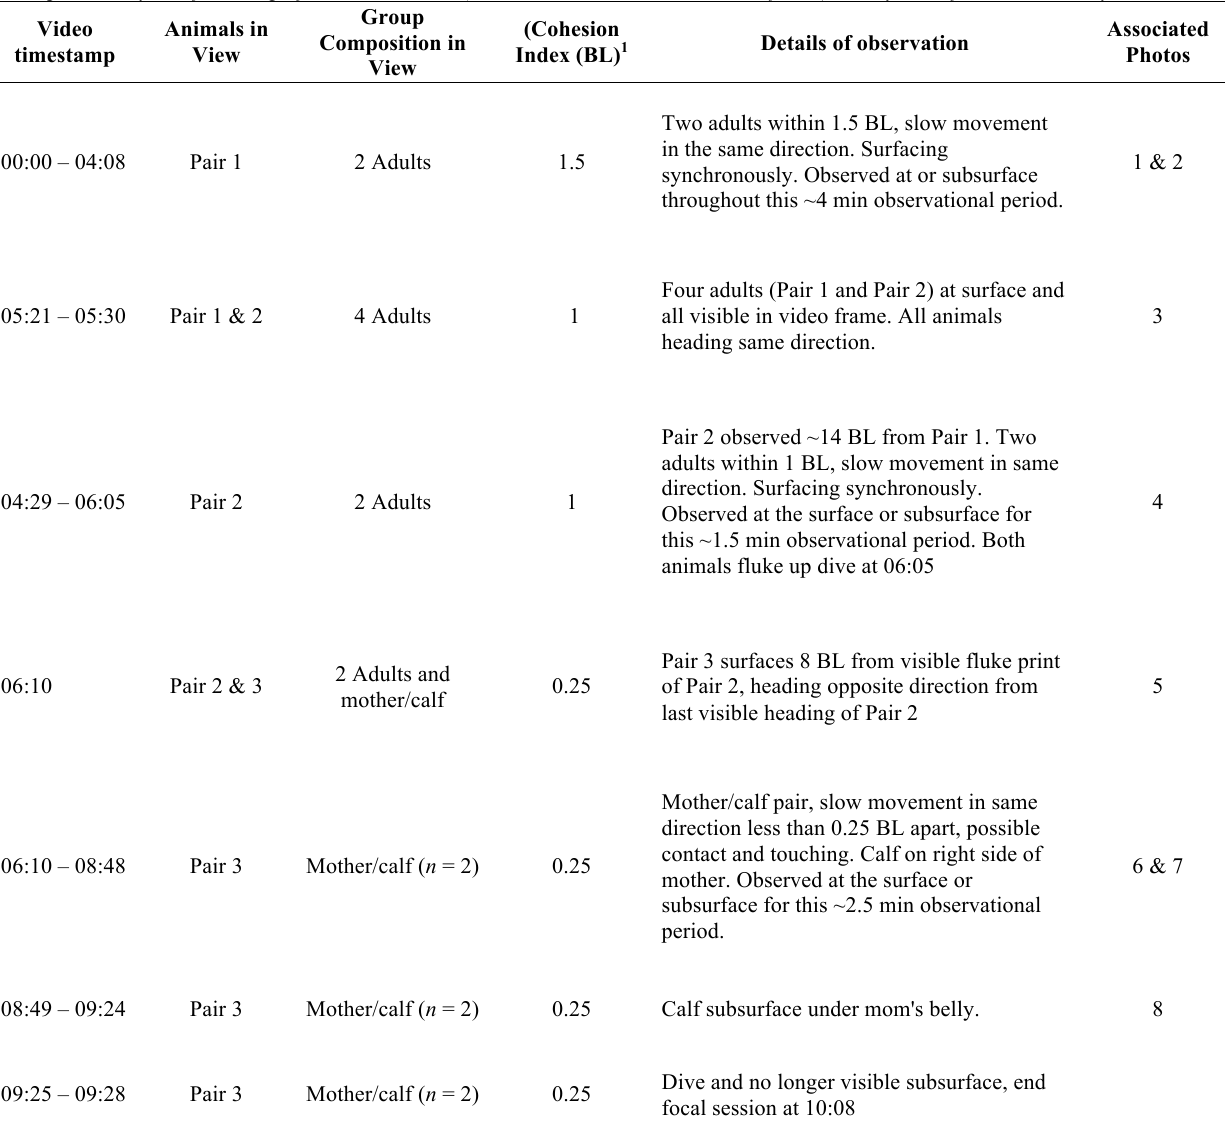
Descriptive Analyses of a Group of Six Blue Whales (Four Adults and One Mother/Calf Pair) in July 2010 from Video